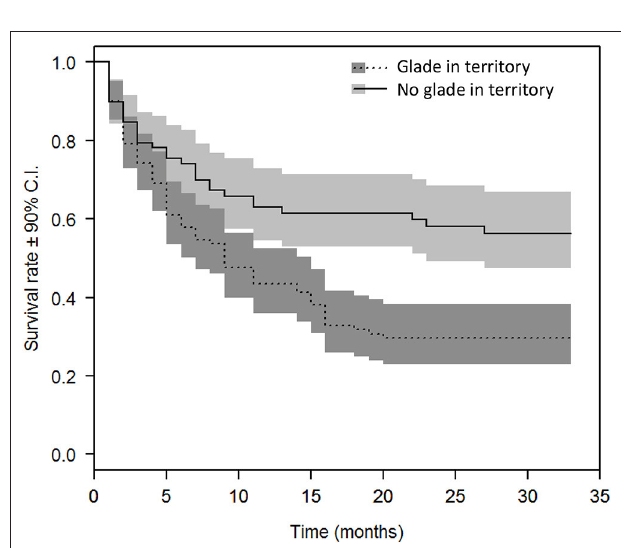
FIGURE 5 | Survival rates and 90% confidence intervals from Cox proportional hazards models for hartebeest with territories containing vs. lacking glades. Survival for hartebeest with territories containing glades is roughly half that of those whose territories lack